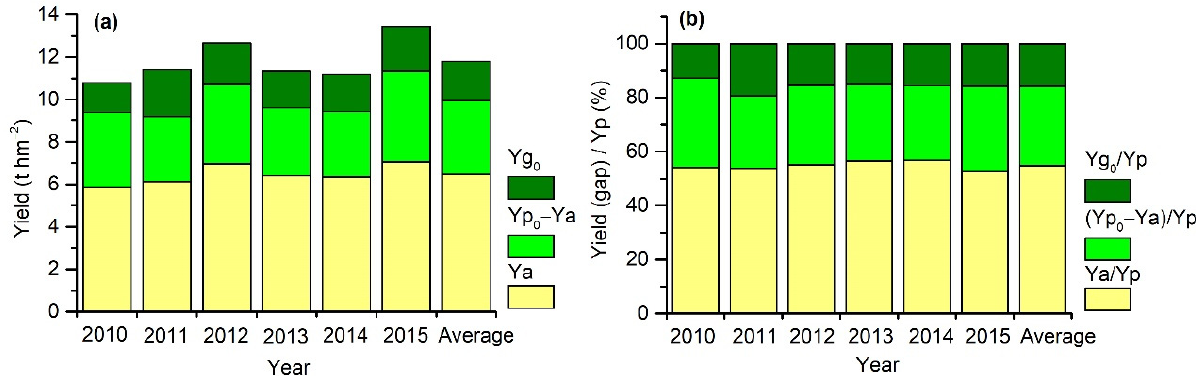
Figure 7. Annual and the average of the annual regional Yg 0 , Yp 0 –Ya, and Ya ( a ), and proportions of regional Yg 0 , Yp 0 –Ya, and Ya in regional Yp ( b ) in the period 2010 to 2015. Table 1. Ya, potential yield limited by suboptimal SDT (Yp 0 ), Yp, Yg, ratio of Yg to Yp (Yg/Yp), ratio